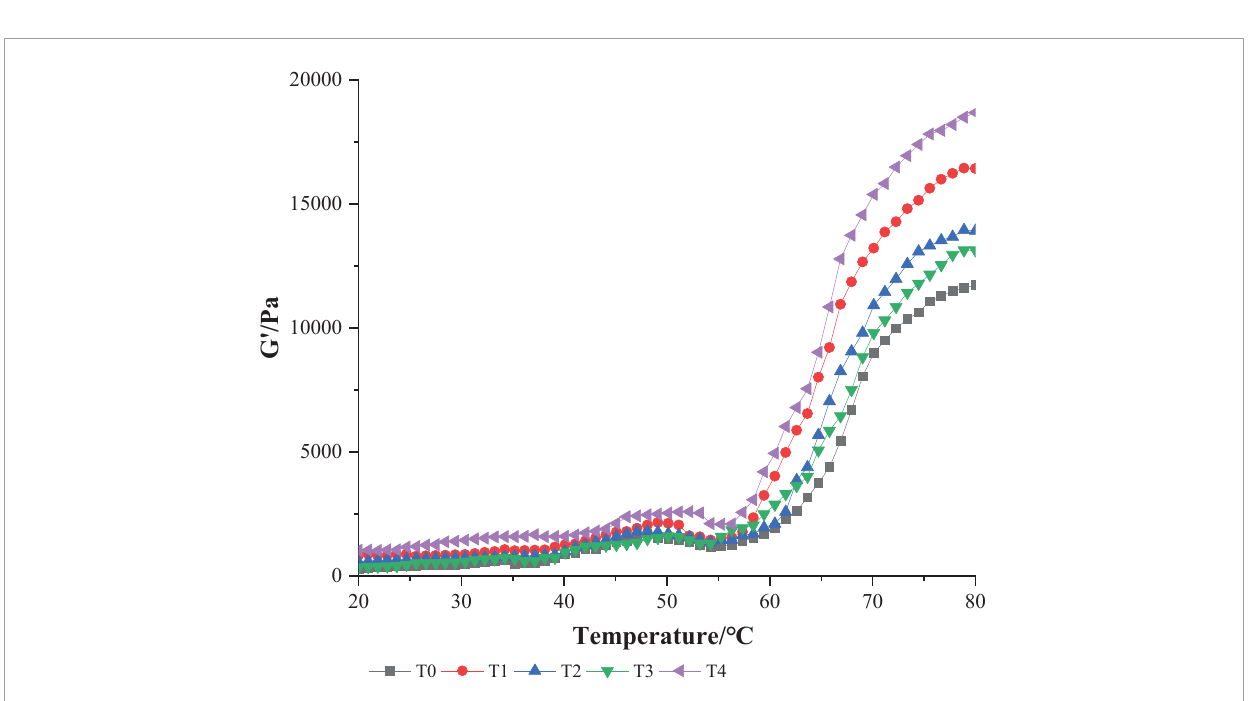
FIGURE3 Effect of composite dietary fiber on rheological properties of MP gel. T0: control group; T1: 6.06% chaff dietary fiber; T2: 6.06% soybean hull dietary fiber; T3: 6.06% inulin; T4: 1.40% chaff dietary fiber +1.42% soybean hull dietary fiber +3.24%